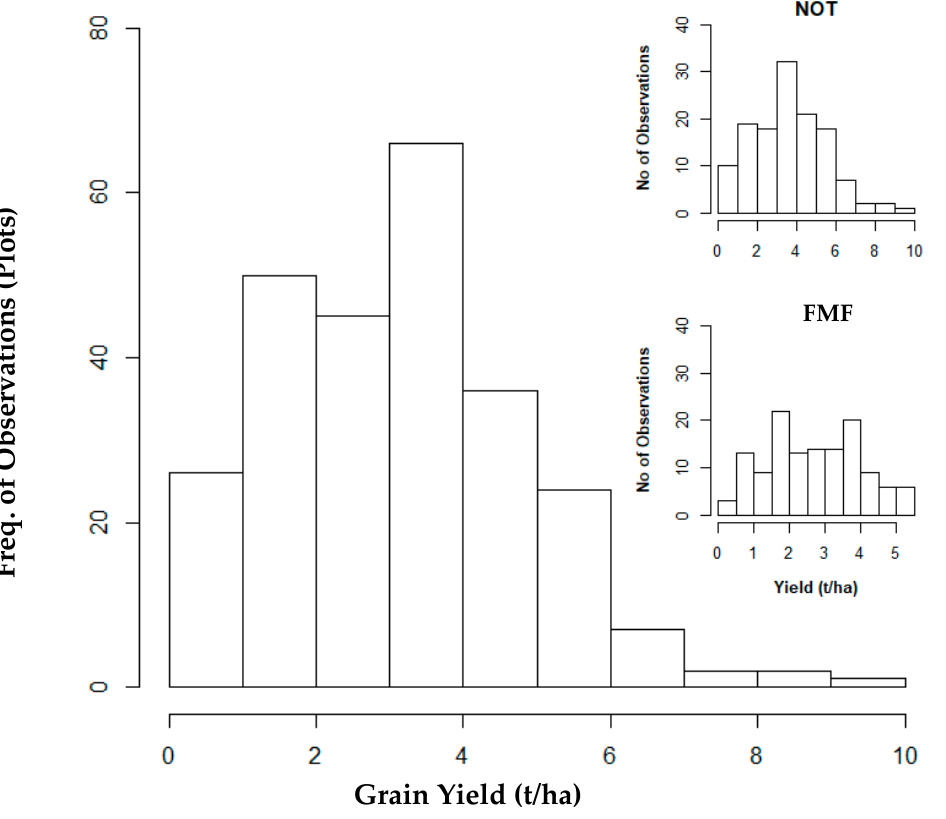
Figure 2. Frequency of estimated maize grain yield in smallholder farms across multilocational nutrient omission trials (NOTs) and farmer managed fields (FMF).